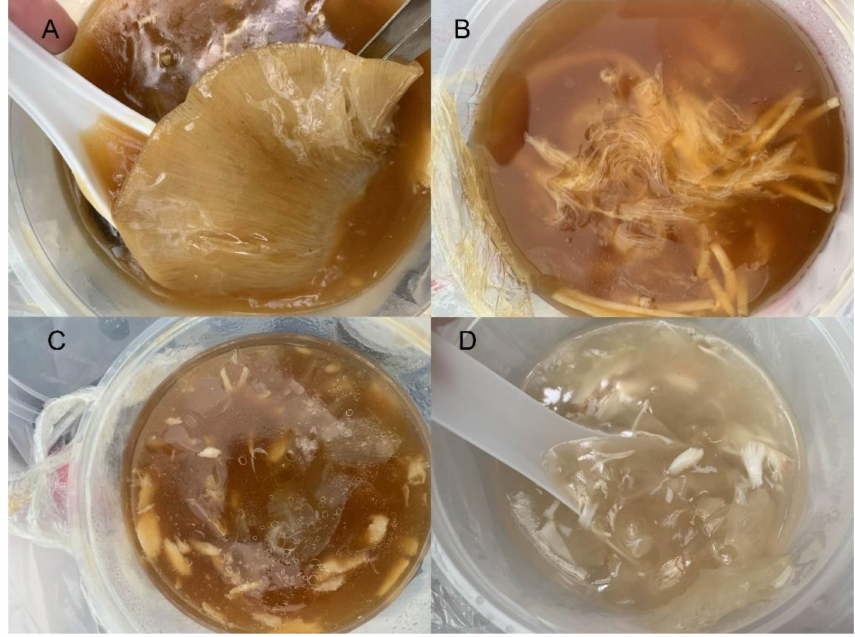
Figure 1. Examples of the products purchased in this work. ( A ) = soup 1, ( B ) = soup 2, ( C ) = soup 3 and ( D ) = soup 4. See Table 1 for the species identified in